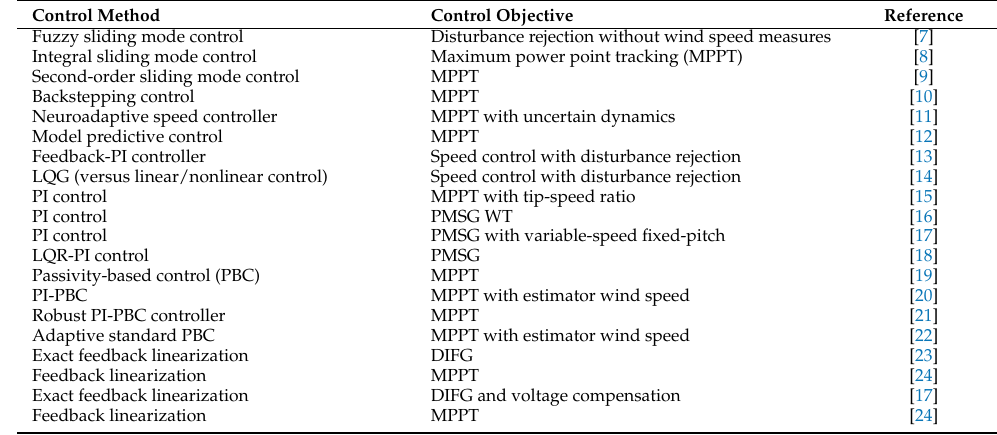
Table 1. Control techniques applied to